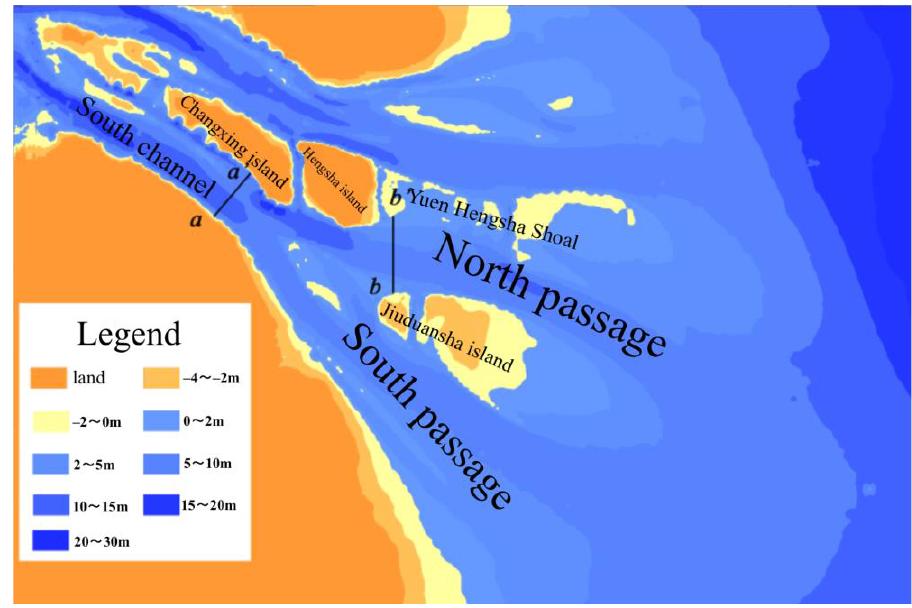
Figure 5. Positions of the sections in the North Passage before the project.